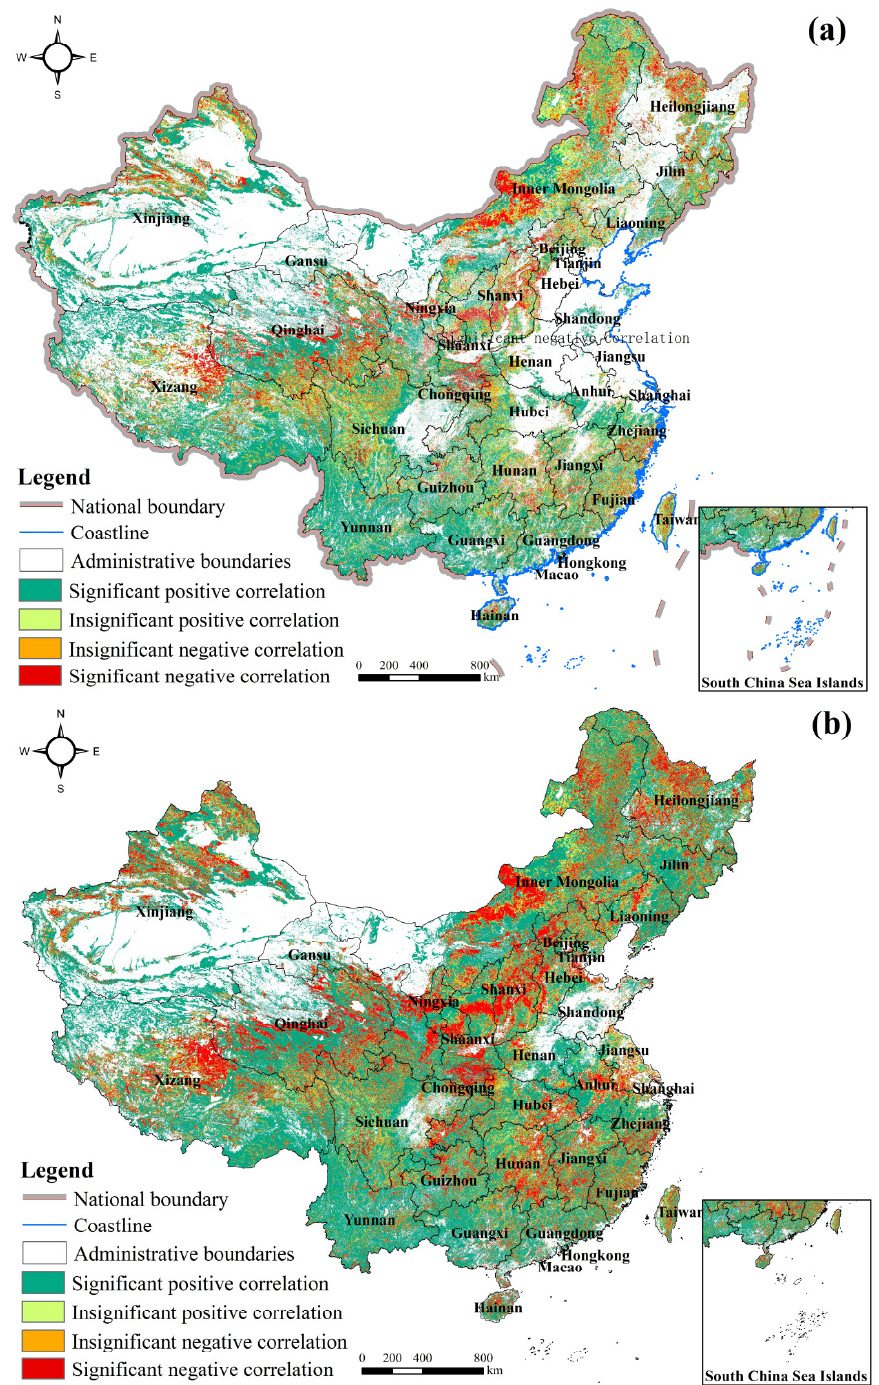
Figure 10. Correlation of CS in CES with ( a ) temperature and ( b ) precipitation.